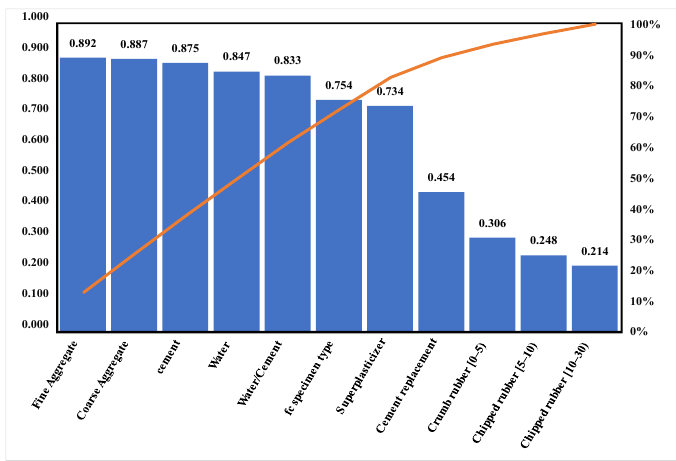
Figure 2. Analysis of sensitivity